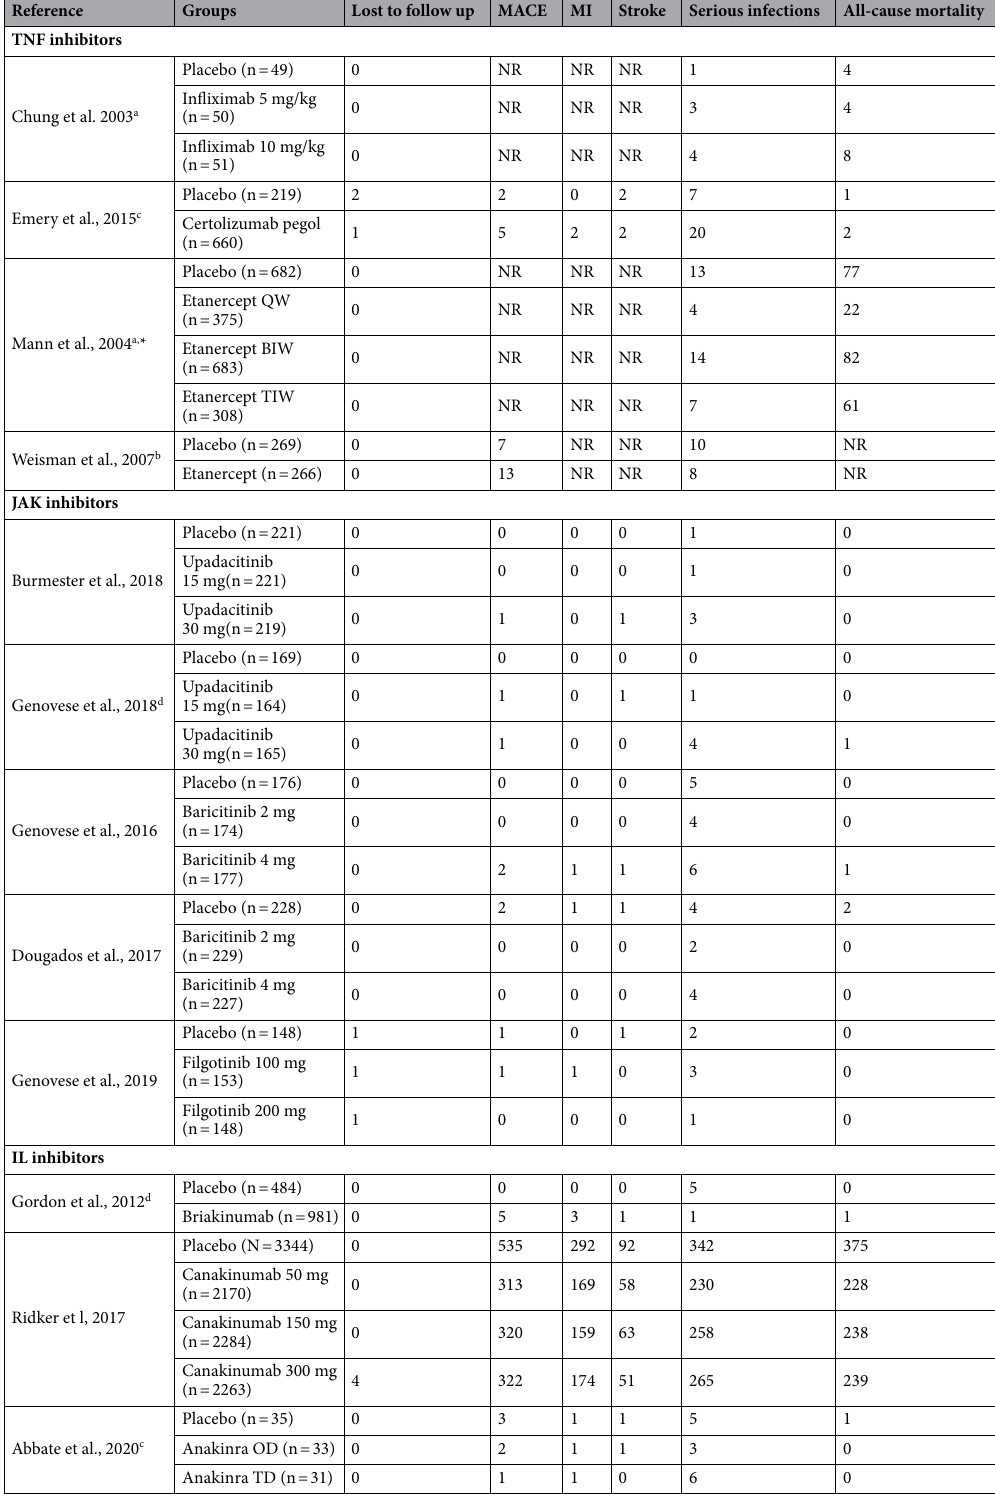
Table 2. Outcome data from all included studies testing the effect of DMARDs. a CV death used for MACE calculation is death or hospitalization due to CHF. b MACE calculated from percentage and included heart failure, coronary artery disease, MI and cerebrovascular events. No individual event data was given. c Data taken from clinical trial page. d Placebo group is being randomized into intervention after 12 weeks. Therefore, we considered only data until 12 weeks. MACE, Major adverse cardiovascular events; MI, Myocardial infarction; CV death, Cardiovascular death; NR, Not